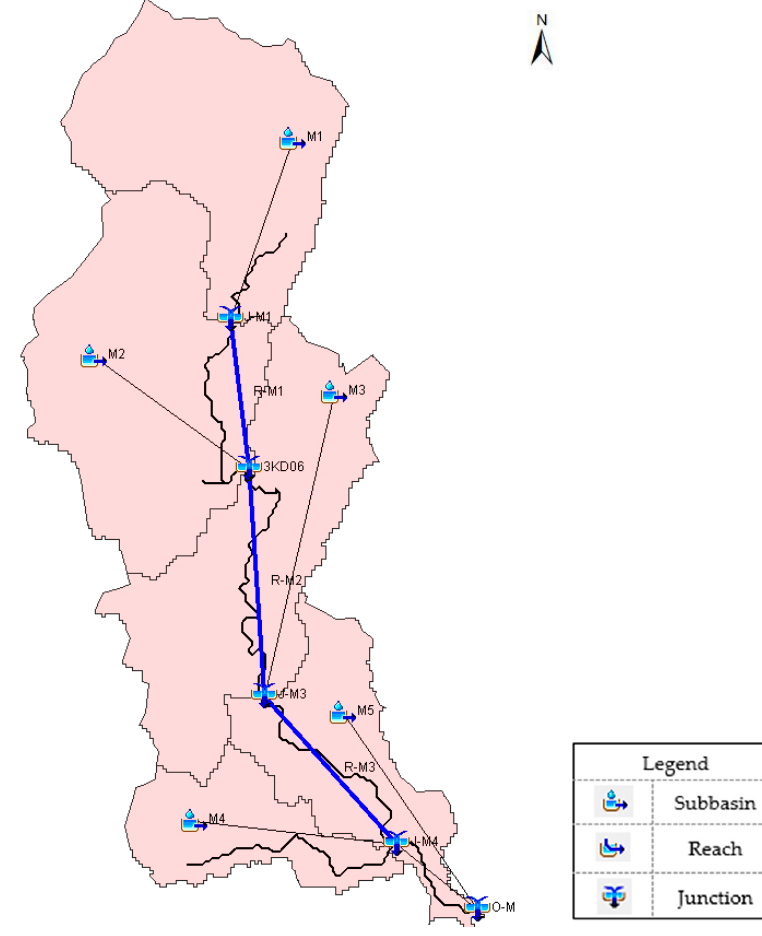
Figure 4. Mkurumudzi basin model (Source